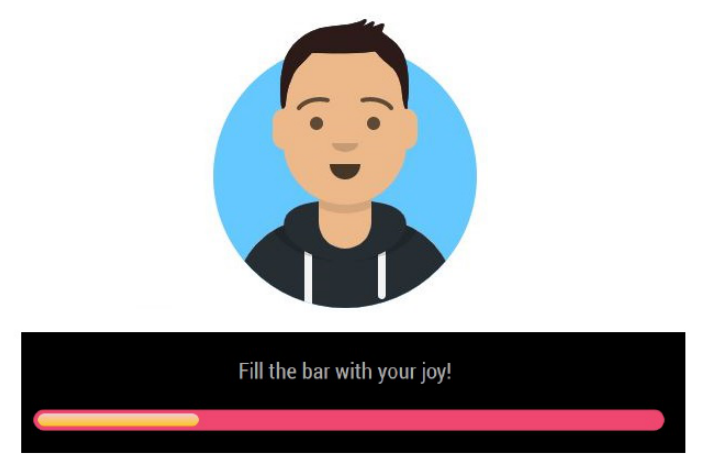
Figure 4. Example of user’s avatar with his